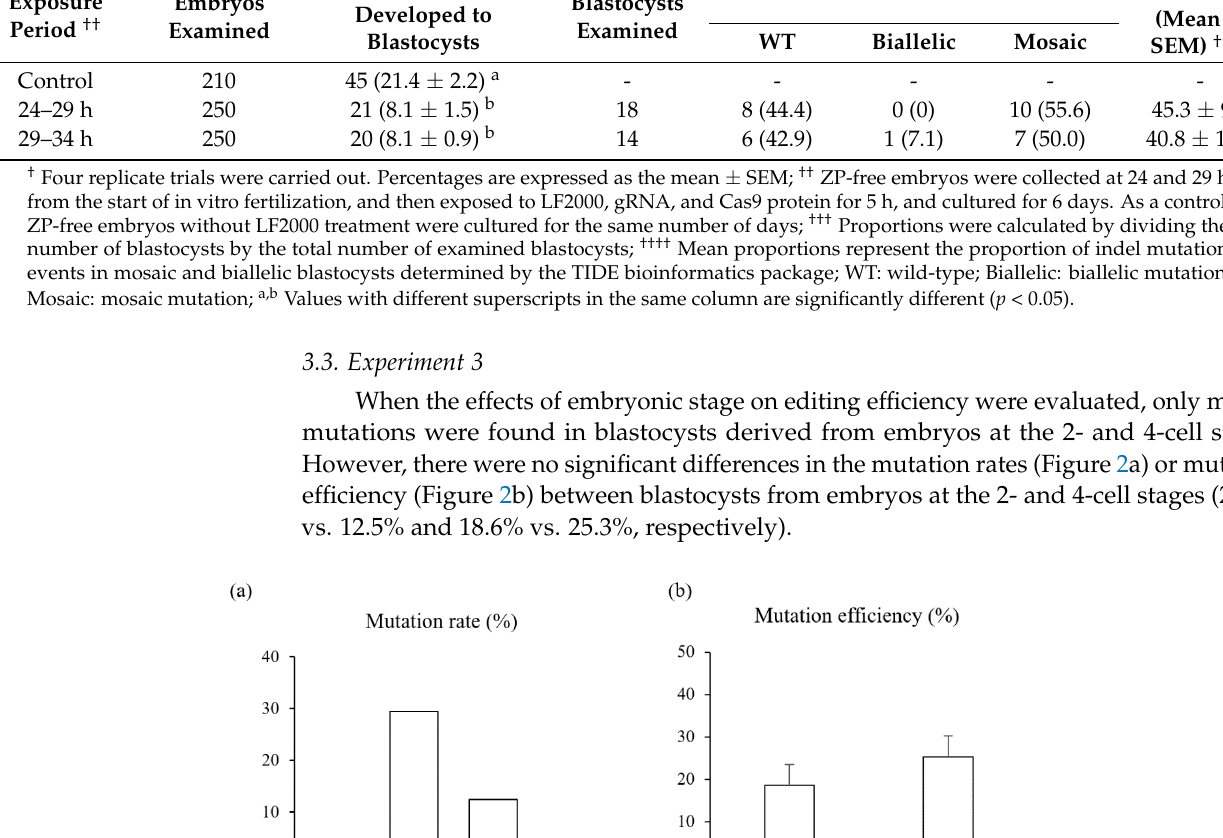
Table 2. Development of zona pellucida (ZP)-free embryos subjected to lipofection-mediated gene editing with gRNA targeting PDX1 after IVF † .